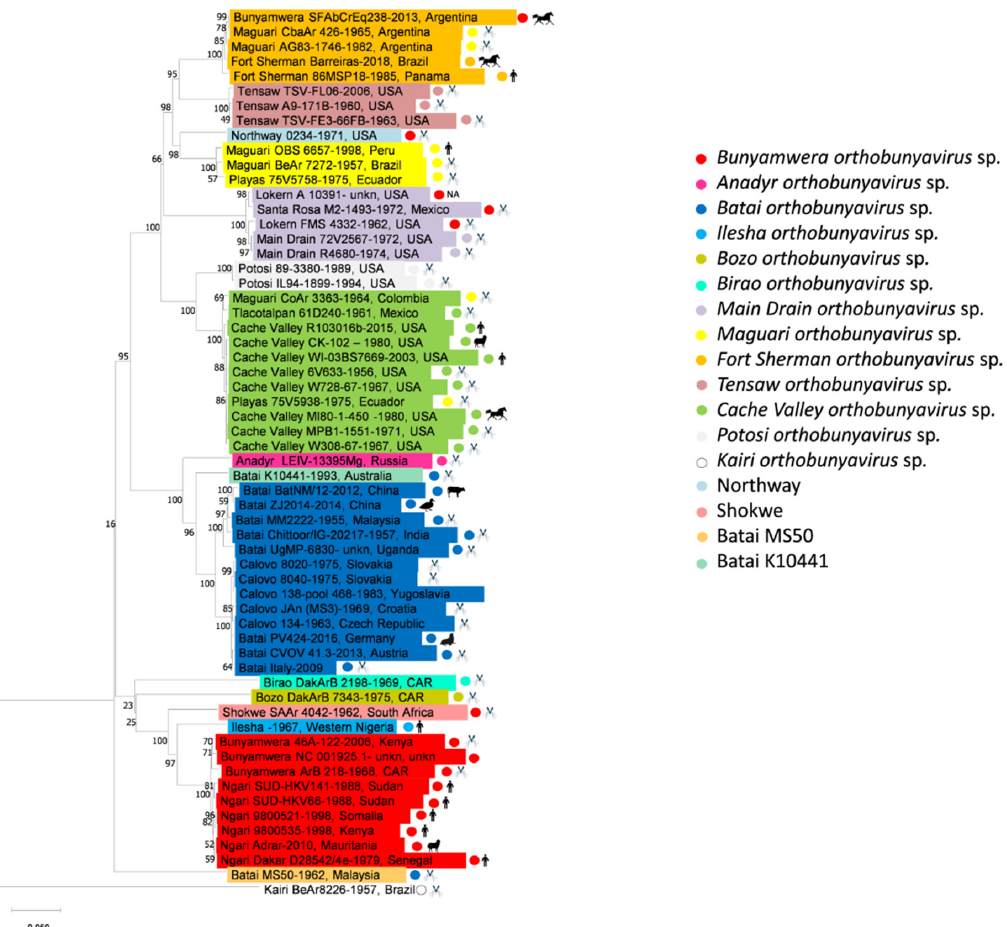
Figure 1. Phylogenetic tree of Bunyamwera serological group members based on L segment sequence (amino acid level). The tree was rooted to the genome of the La Crosse virus (EF485032). Alignments of amino acid sequences were performed using MEGA v.11 software using the MUSCLE algorithm. Phylogenetic trees were reconstructed using maximum-likelihood estimation based on the general time-reversible (GTR) parametric model allowing gamma-distributed frequency variation between sites and a proportion of invariant sites in the sequence. The robustness of the tree was tested using 1000 bootstrap replicates. The GTR substitution model evaluated 24 models with various combinations of parameters of nucleotide substitution on the basis of maximum-likelihood fits and selected the best model among them. Attribution to the orthobunyavirus species according to ICTV is indicated by a colored dot. The real attribution to the orthobunyavirus species is indicated by colored highlighting. Isolate source listed as an animal